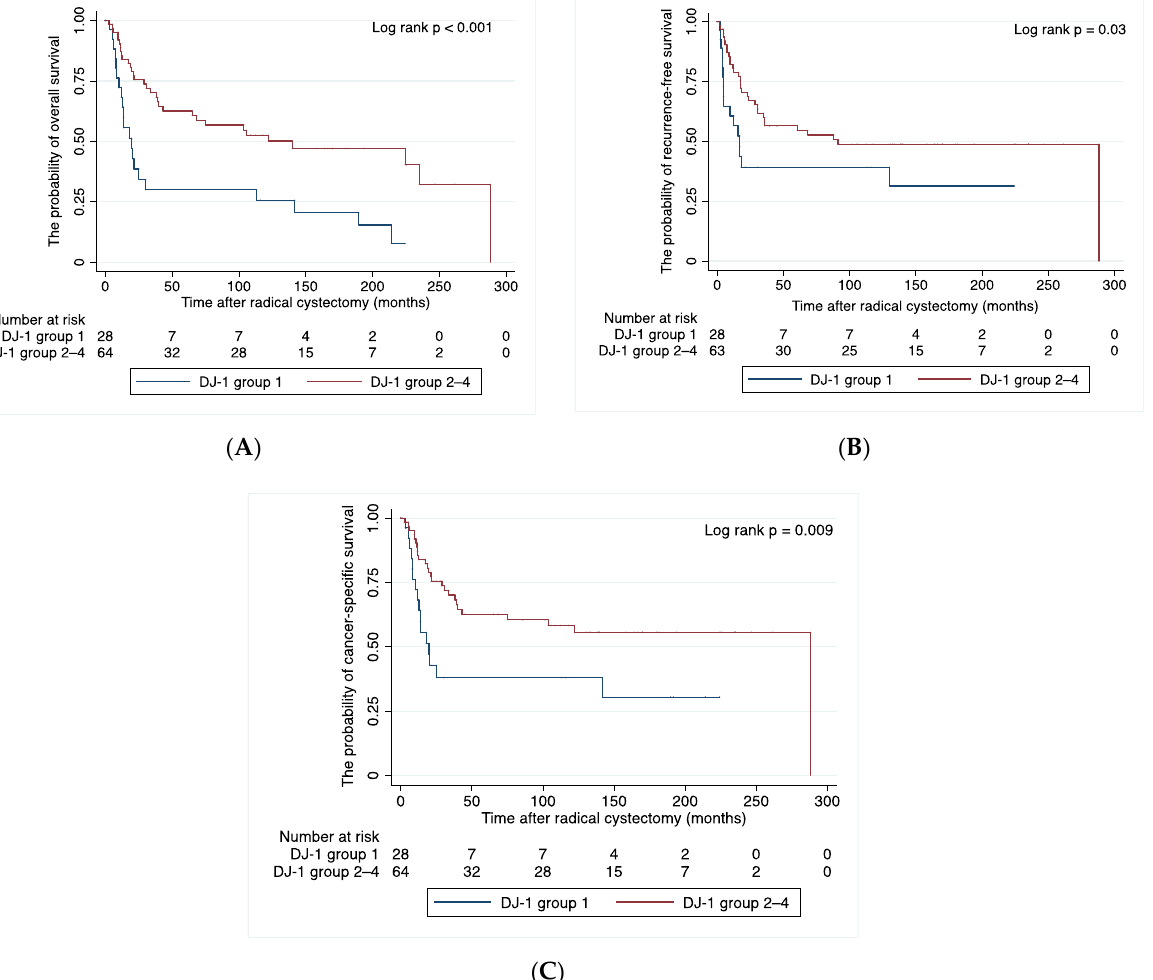
Figure 5. Probability of ( A ) overall survival, ( B ) recurrence-free survival, and ( C ) cancer-specific survival after radical cystectomy for Group 1 and Group 2 － 4. Group 1 — cytoplasm-positive, nucleus-negative; Group 2 — cytoplasm-positive, nucleus-positive; Group 3 — cytoplasm-negative, nucleus-positive; Group 4 — cytoplasm-negative, nucleus-negative. In Cox ’s proportional hazards regression analysis, DJ-1 expression and lymph node metastasis were associated with OS, recurrence-free survival and CSS (Table 3). Table 3. Multivariate Cox proportional hazards regression analyses of DJ-1 expression and clinico- pathologic findings for predicting clinical outcome after radical cystectomy.